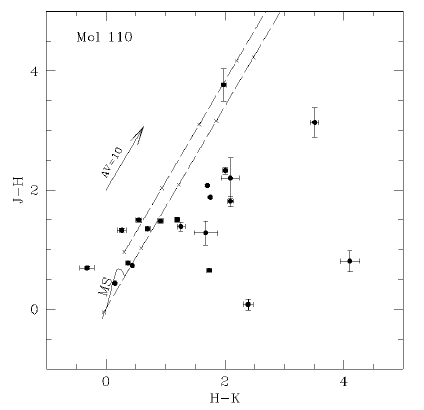
Figure 3: J-H versus H-Ks diagram relative to a region of 20arcsec around the IRAS position.